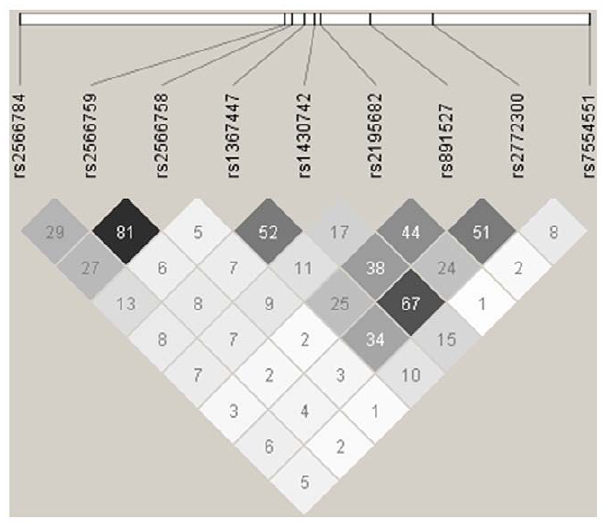
Figure 1. The pair-wise LD between GPR177 SNPs associated with bone health parameters. (black r 2 =1, white r 2